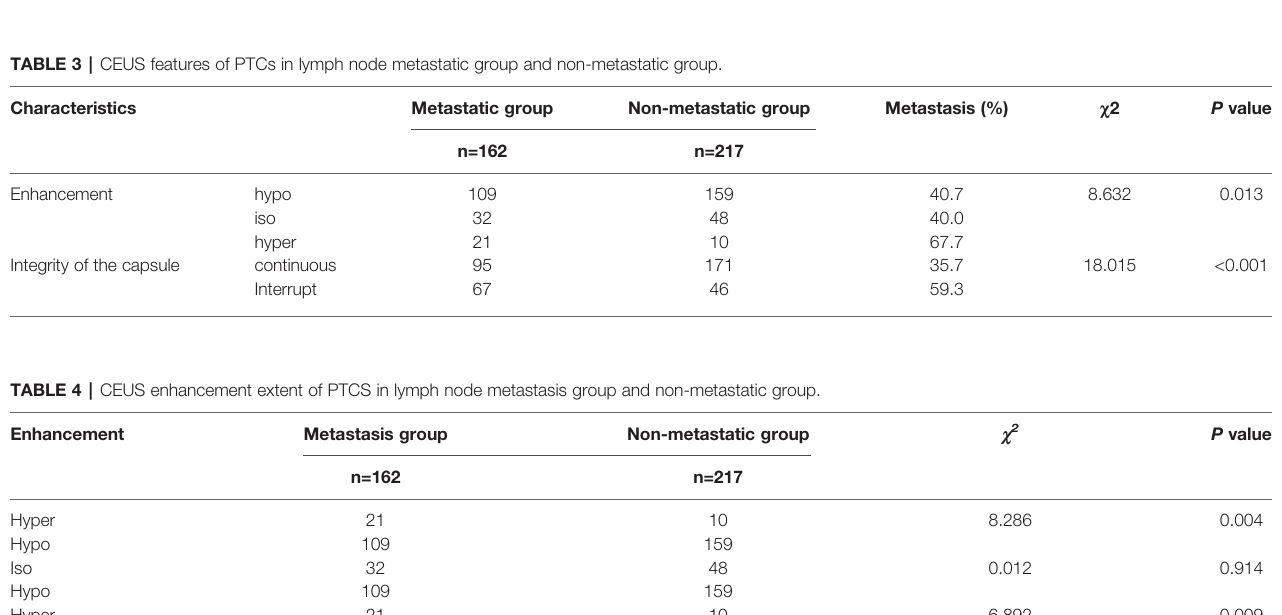
FIGURE 2 | A 36-year-old woman with PTC. (A) Preoperative ultrasound images showing that the size of the tumor was approximately 1.81*1.30*1.09 cm in the left lobe, and microcalci fi cation was detected. (B) Transverse sonogram showing that the contact range with the capsule was >50%. (C) CEUS showing hyperenhancement of the whole nodule. (D) Con fi rmation by surgical pathology as CLNM in ipsilateral level VI (HE, original magni fi cation, ×100).